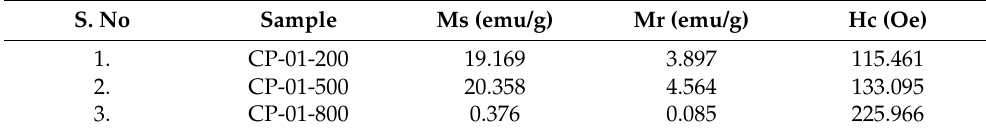
Figure 6. M-H loop of titanium ferrite NPs synthesized with ( a ) different calcined temperatures and ( b ) magnetism behavior of samples in physical mode. Table 1. Magnetic parameter of titanium ferrite NPs calcined at different